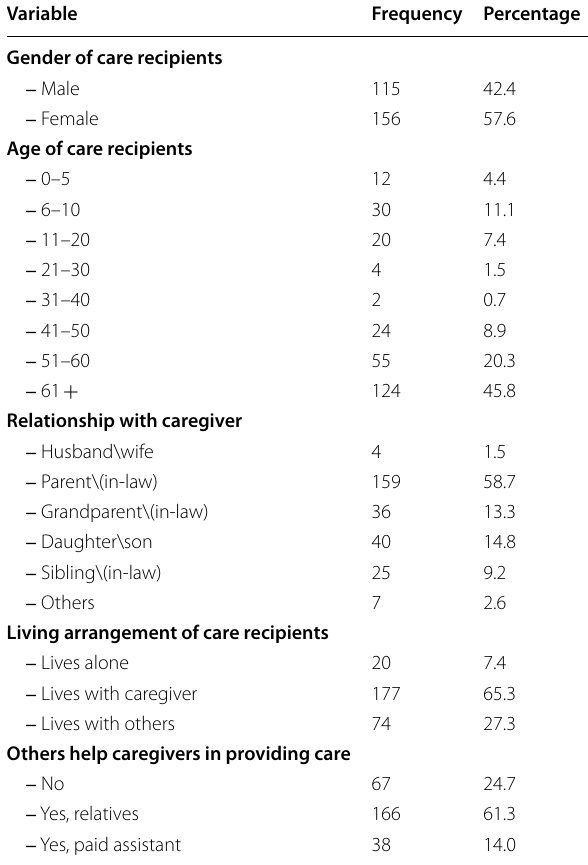
Table 2 Characteristics of recipients of informal care in Saudi Arabia, 2015 ( n 271) =